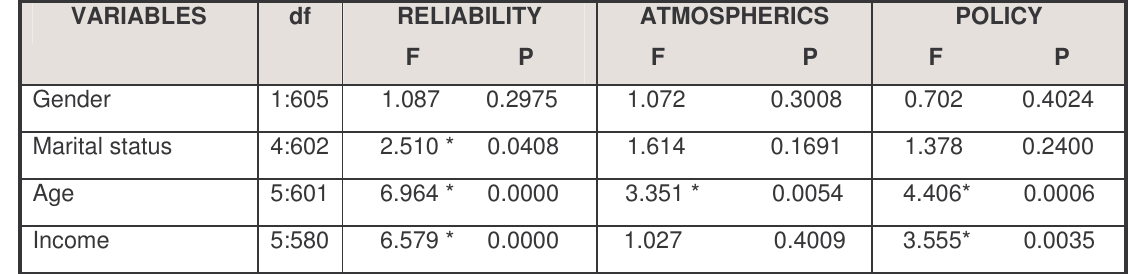
VARIABLES df RELIABILITY F P